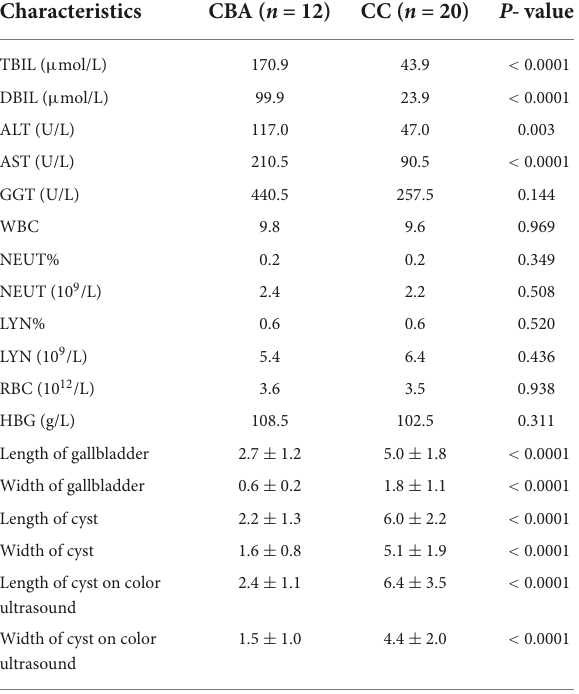
TABLE 2 Comparison of clinical and biochemical information between the CBA and CC groups.